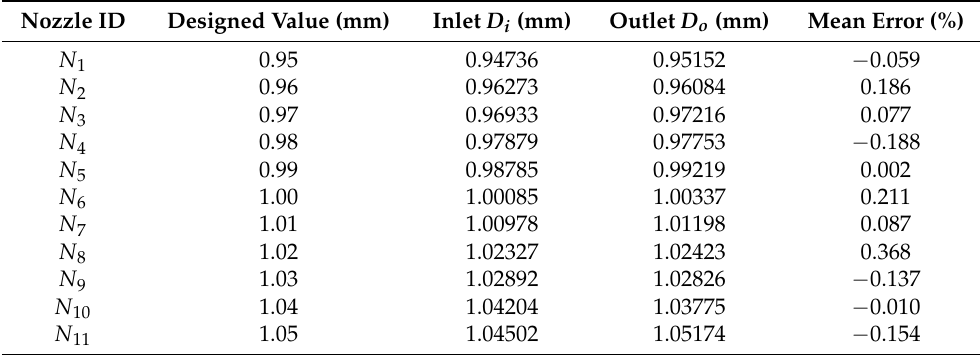
Table 1. Geometric dimension of nozzles measured by the optical fiber probe system.